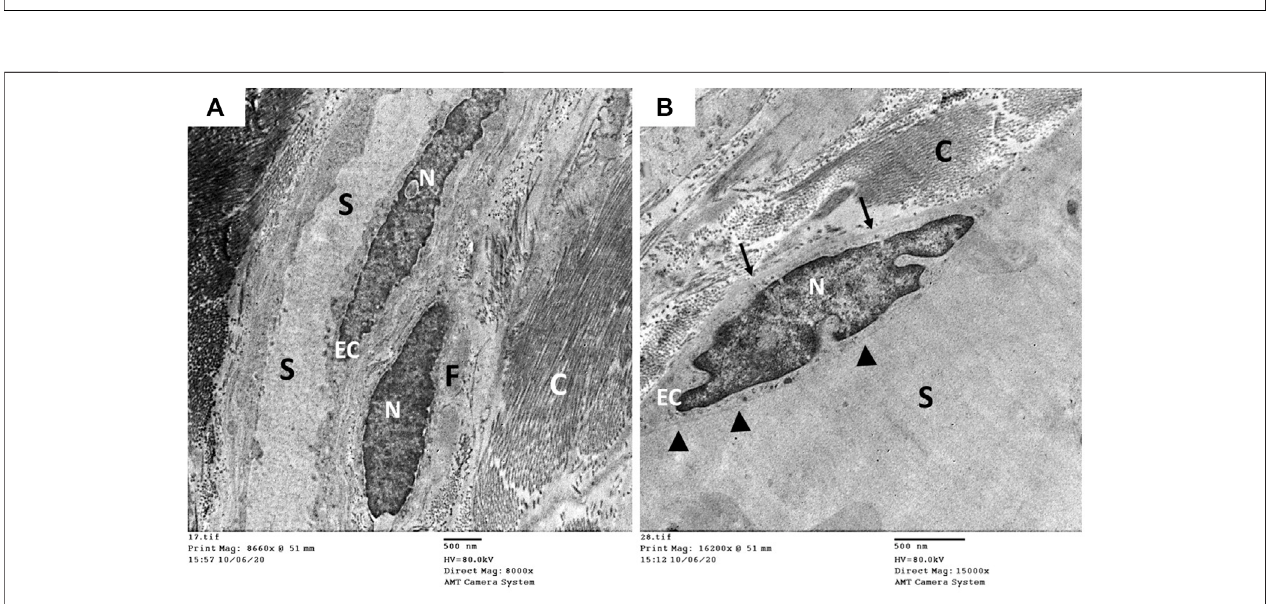
FIGURE 10 | Transmission electron microscopic pictures of the corpus cavernosum of control rat showing (A) wide cavernous spaces (S) lined with endothelial cells(EC)andsurroundedbymaturecollagen fi bers(C)and fi broblasts(F). (B) Theliningendotheliumshowingwellidenti fi ednucleus(N),narrowbasallamina(arrow),and smooth cavernous surface (arrowhead) but lacking the pinocytic vesicles in the cytoplasm.